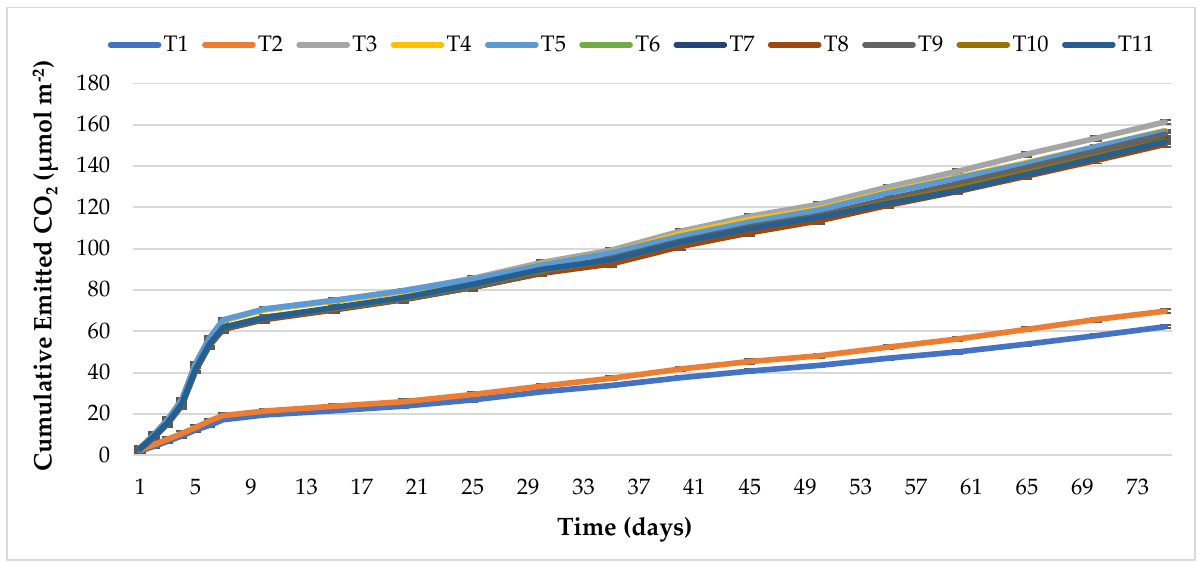
Figure 4. Effect of Treatments on cumulative soil CO 2 flux emission. Bar errors show ± standard error of four replications. T 1 = No treatments and fertilizer (Control), T 2 = Recommended rate of NPK (t ha −1 ), T 3 = 100% dolomitic limestone + 10 t ha −1 rice husk biochar + 100% TSP, T 4 = 100% dolomitic limestone + 10 t ha −1 rice husk biochar + 75% TSP, T 5 = 100% dolomitic limestone + 10 t ha −1 rice husk biochar + 50% TSP, T 6 = 75% dolomitic limestone + 10 t ha −1 rice husk biochar + 100% TSP, T 7 = 75% dolomitic limestone + 10 t ha −1 rice husk biochar + 75% TSP, T 8 = 75% dolomitic limestone + 10 t ha −1 rice husk biochar + 50% TSP, T 9 = 75% dolomitic limestone + 15 t ha −1 rice husk biochar + 100% TSP, T 10 = 75% dolomitic limestone + 15 t ha −1 rice husk biochar + 75% TSP, T 11 = 75% dolomitic limestone + 15 t ha −1 rice husk biochar + 50% TSP.